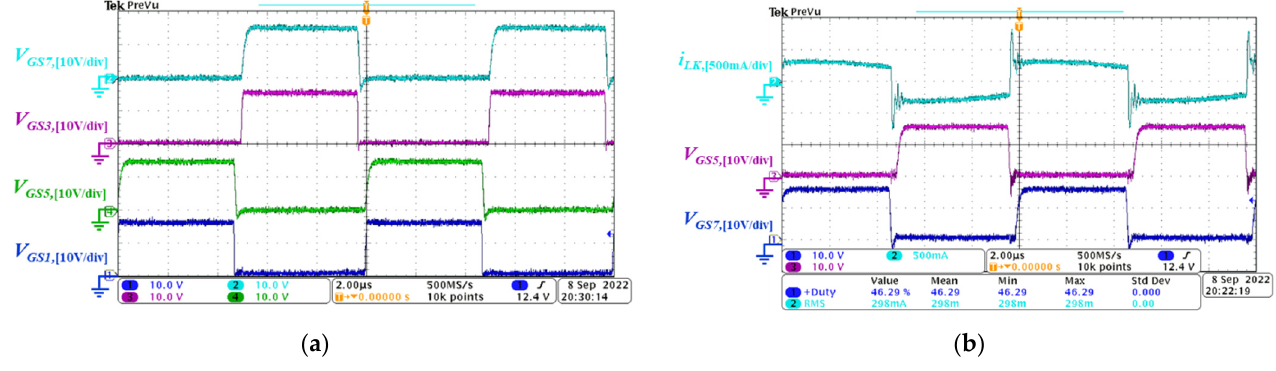
Figure 16. Experimental waveforms of the prototype converter operating in backward power con- version mode (at 10 W output power): ( a ) waveforms of gate signals V GS1 , V GS3 , V GS5 and V GS7 ; ( b ) waveforms of gate signals V GS5 , V GS7 and inductor current i LK .